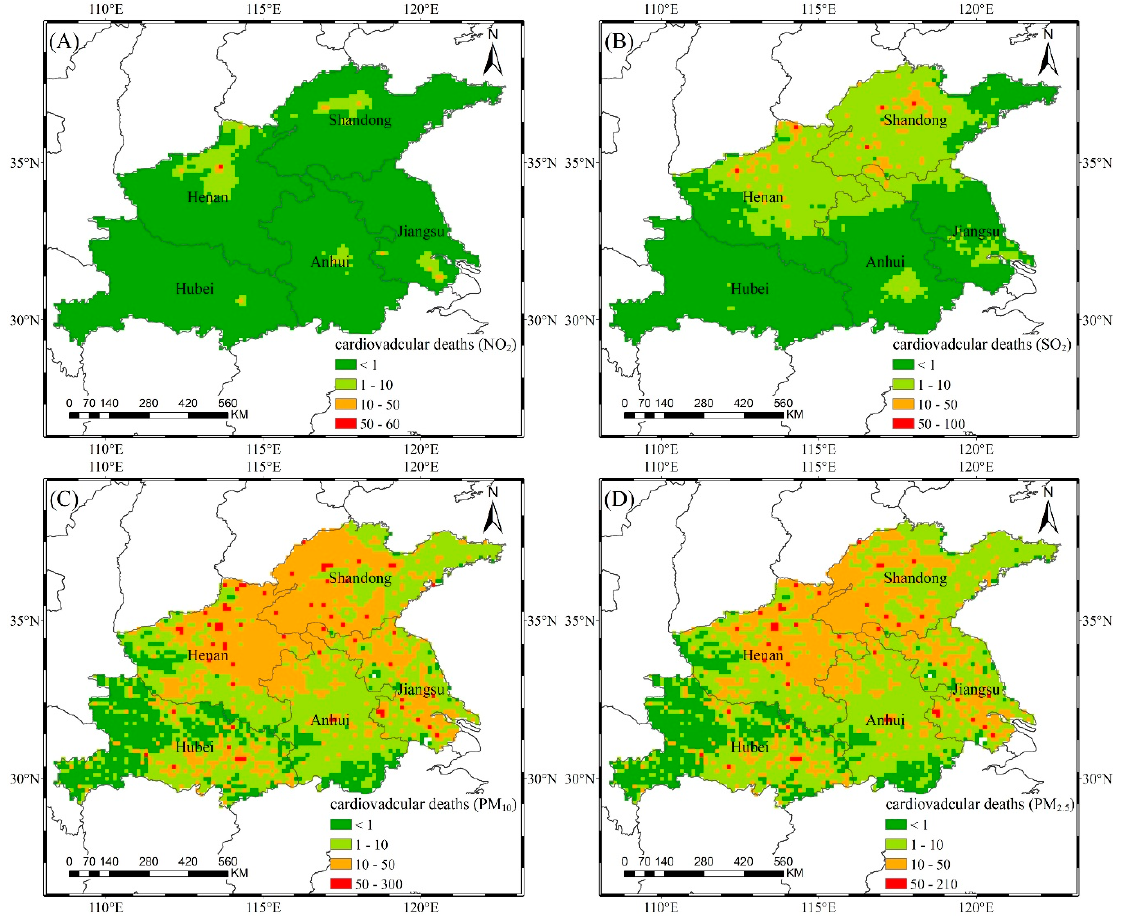
Figure 7. The number of cardiovascular deaths attributed to NO 2 ( A ), SO 2 ( B ), PM 10 ( C ), and PM 2.5 ( D ).